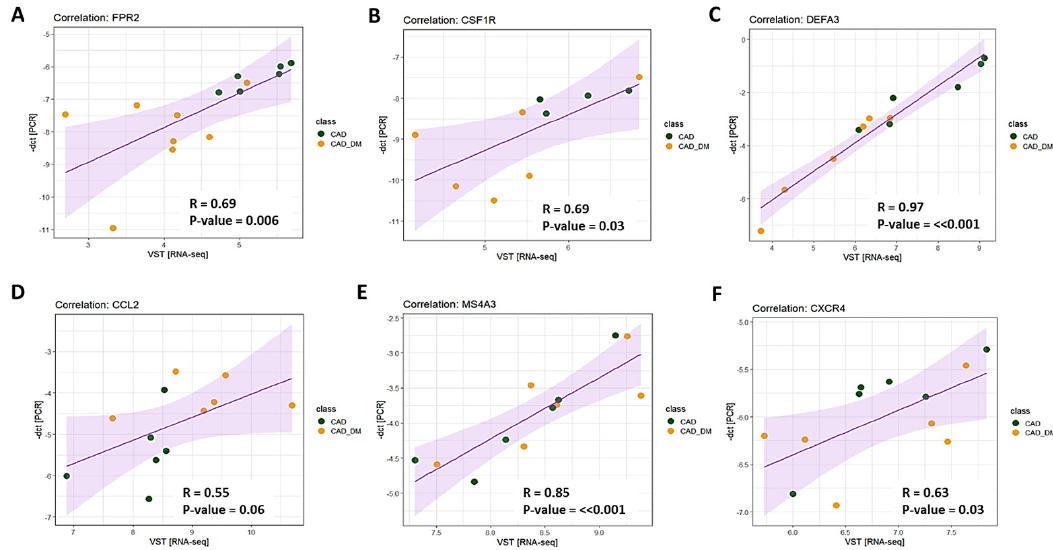
Figure 5. Technical validation of gene expression. The expression level of 6 genes was assessed using RT-qPCR single assays and RNA-seq. Pearson’s correlation coefficient (R) was computed to evaluate the strength of association between the two methodologies. The 95% confidence interval of the trendline (purple line) is depicted in light purple. Data are plotted as -dct (y-axis) versus log-normalized value (x-axis) for FPR2 (panel A ), CSFR1 (panel B ), DEFA3 (panel C ), CCL2 (panel D ), MS4A3 (panel E ), and CXCR4 (panel F ). The R coefficient as well as the corresponding p -values for each gene are shown in the relative panel.